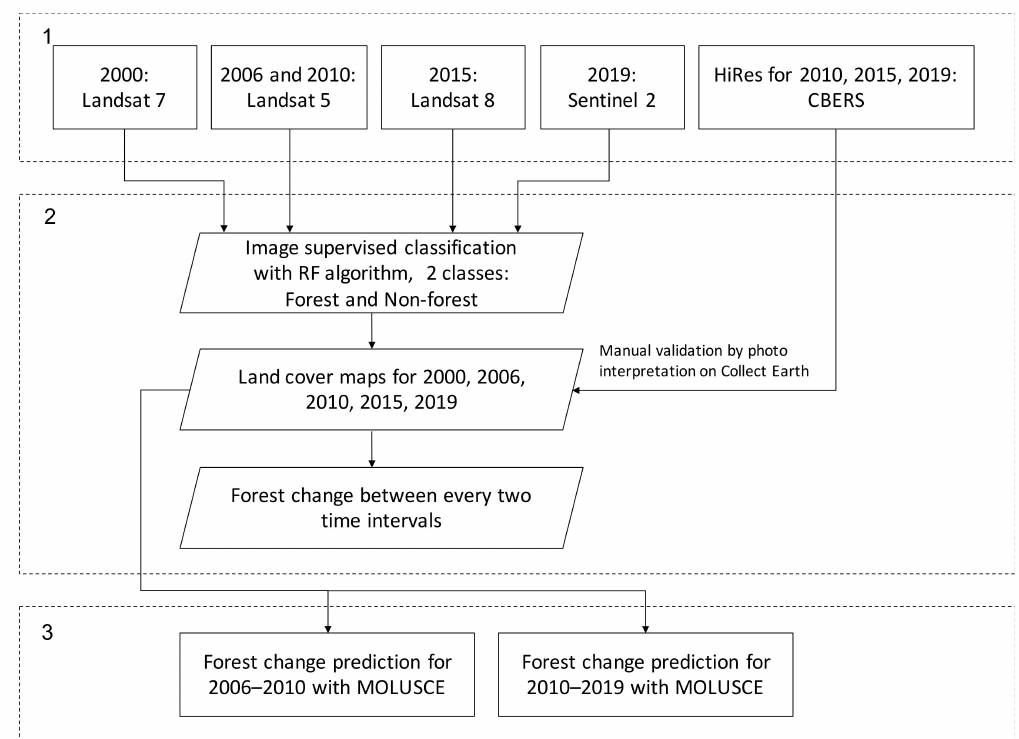
Figure 3. The workflow of the processing. It is divided into three main steps (delimited by hatched lines): The first step highlights the input datasets; the second step organizes the performed land cover classifications and the third step depicts the forest change prediction. MOLUSCE: Modules for Land Use Change